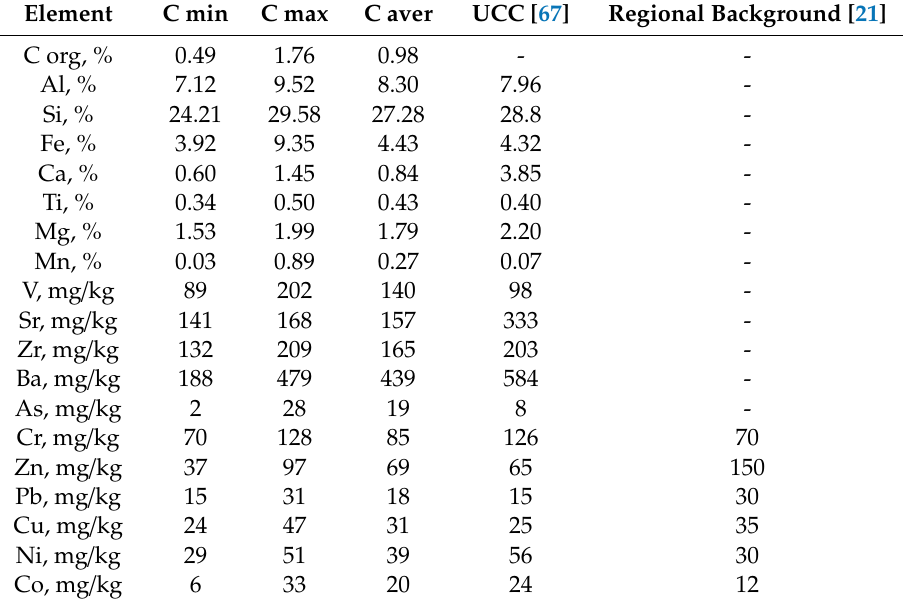
Table 6. Minimal, maximal, and average element contents in the surface sediments of the Barents Sea. Element C min C